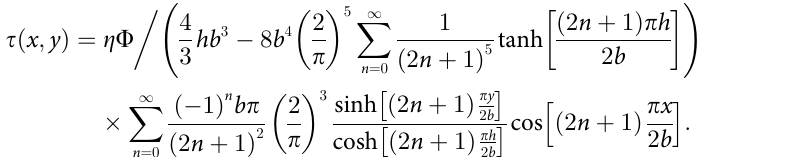
S1 Fig. Immunofluorescence image sequence for TNF- α treatment. Maximum projection of representative immunofluorescence images marking the actin cytoskeleton via phalloidin